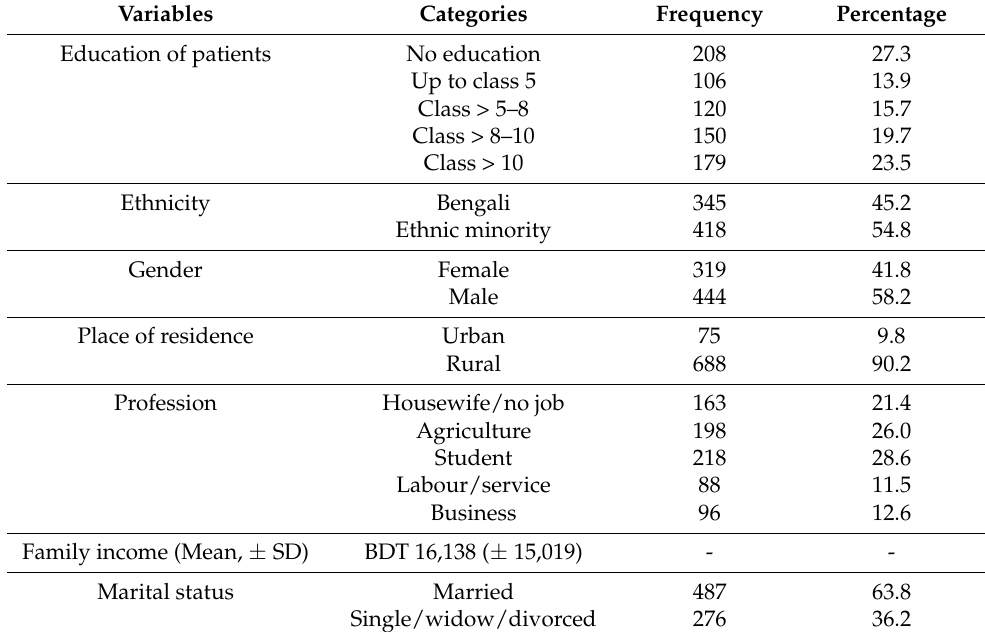
Table 1. Demographic and socio-economic characteristics of study participants (N =